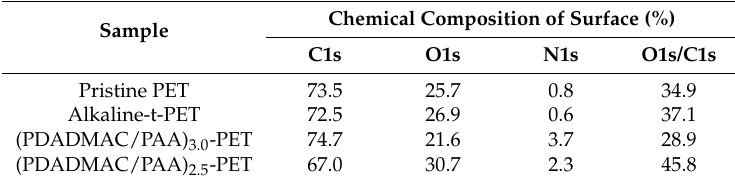
Table 2. The relative peak areas of C1s spectrum of different PET fabrics.